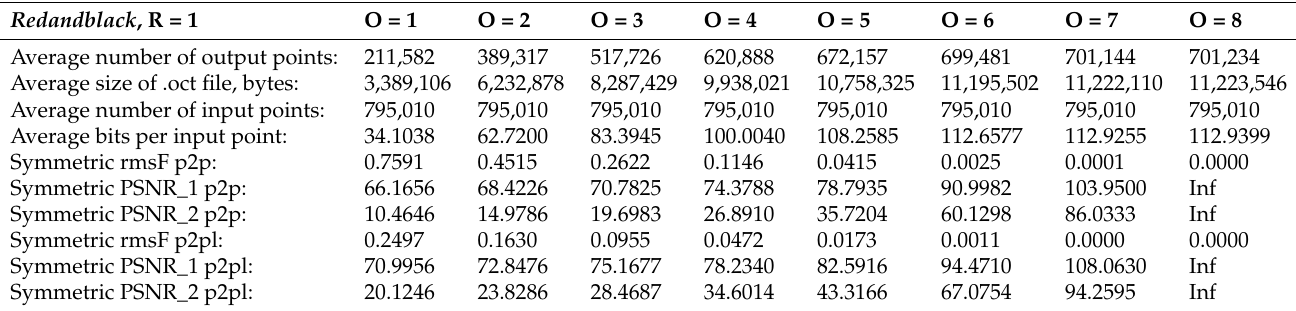
Table 13. Octree reduction using 3DTK toolkit, with voxel size “R” = 1 and different parameters for randomized octree based point reduction with “O” points per voxel, for the Redandblack point cloud.